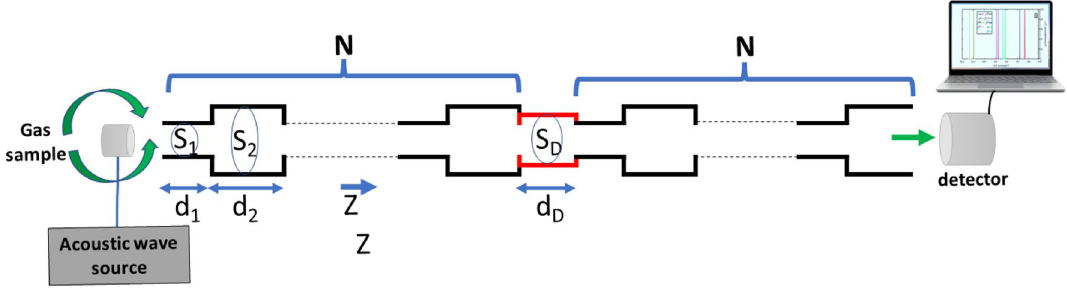
Figure 1. The schematic of the suggested PnC gas sensor with tube sequence of (M 1 M 2 ) N M D ( M 1 M 2 ) N